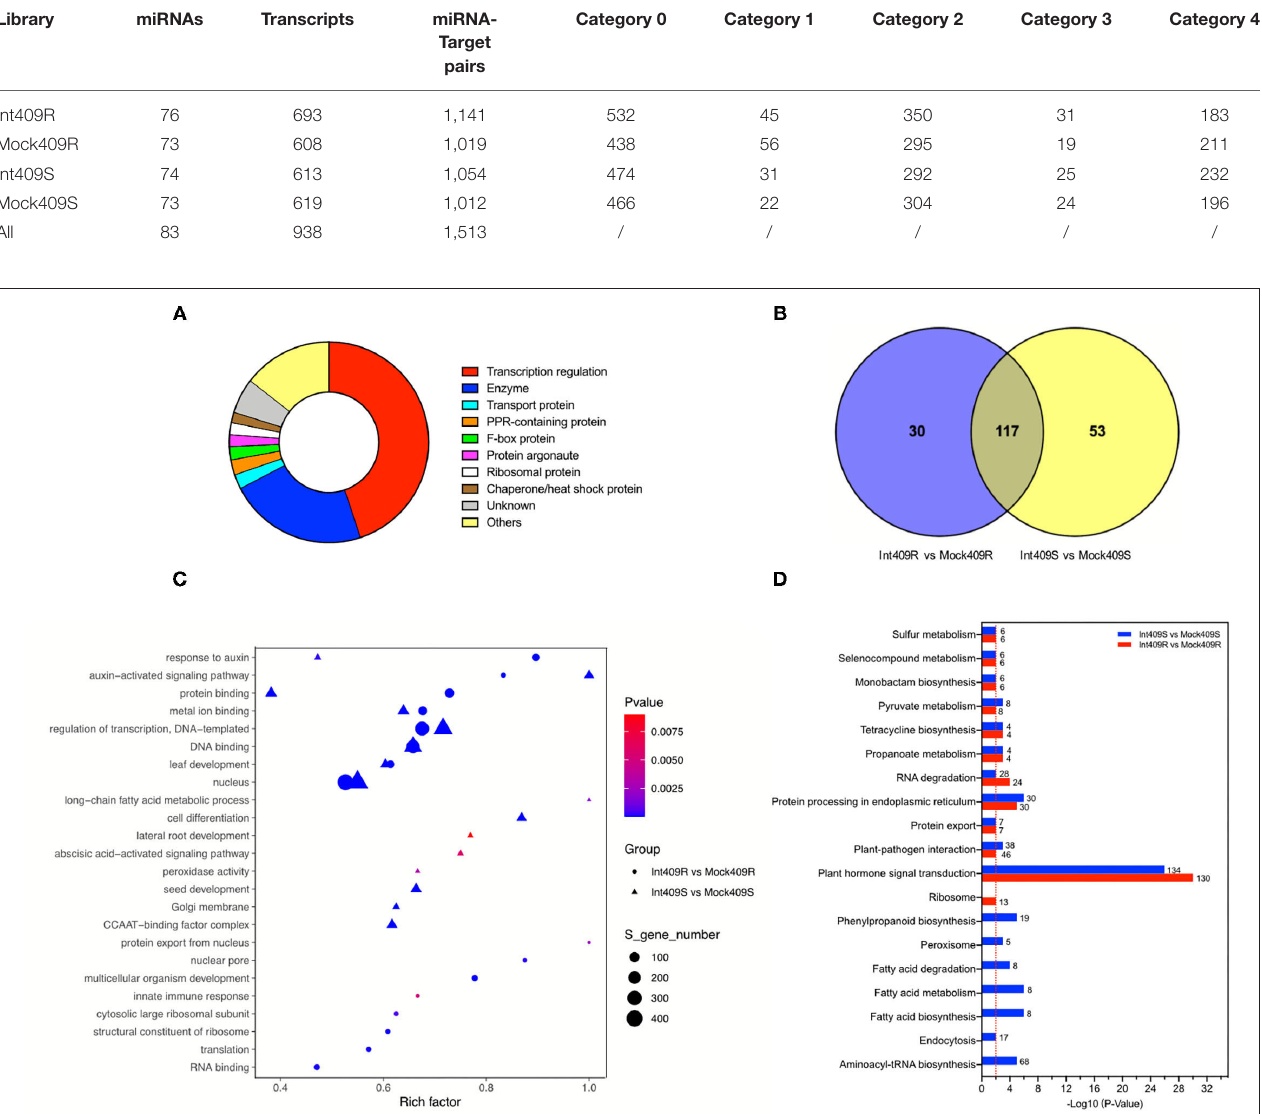
FIGURE 3 | Function annotation and enrichment analysis of target transcripts. (A) Functional classification of all detected targets, (B) Venn diagram of the number of Gene Ontology (GO) terms, (C) GO enrichment, and (D) Kyoto Encyclopedia of Genes and Genomes (KEGG) enrichment analyses in comparison